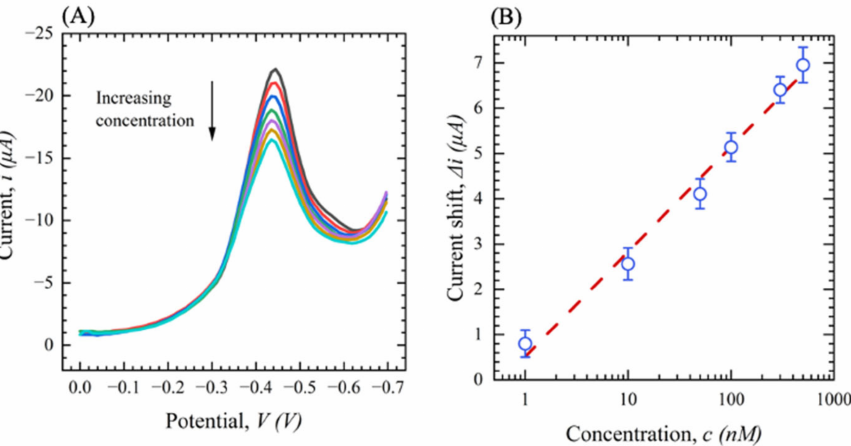
Figure 10. ( A ) SWV for functionalized sensors with different concentrations of S protein from (0–500 nM) in 0.1 M PBS ( n = 3); ( B ) current shift ( ∆ i ) as a function of S protein concentration in 0 M PBS ( n =